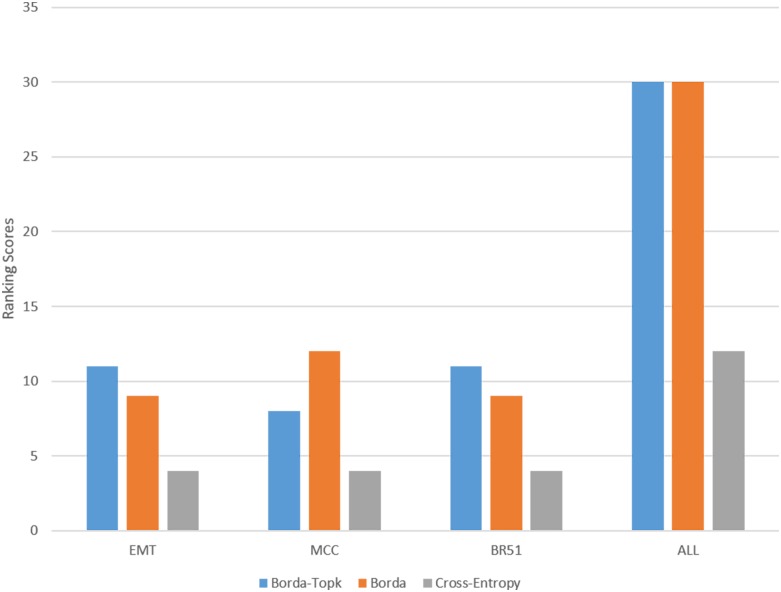
Pearson+IDA+Lasso with different integration approaches.Borda-Topk and Borda (Original Borda from [32]) are better than cross-entropy Monte Carlo in all three datasets.